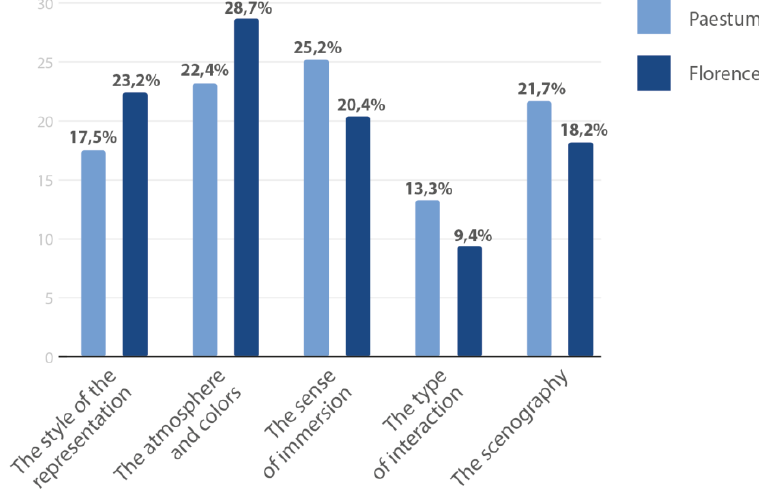
Figure 17. Preferences out of 70 + 75 responses to the question “ What did you feel immersed in exploration?”.